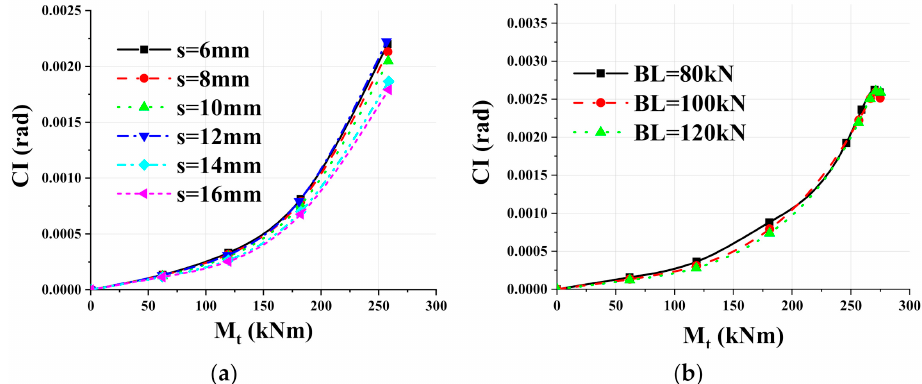
Figure 10. Continuity index-moment curves of connections: ( a ) Thickness of side plate; ( b ) Bolts preload.